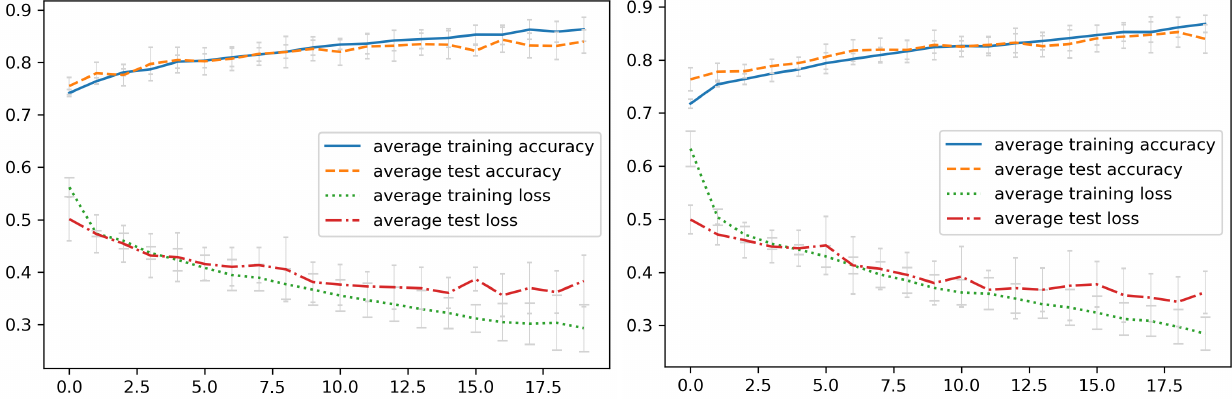
Figure 17. Left image: single dropout. Right image: double dropout. Summary of average results for 20 iterations. Class 0 vs. All. Model: the LeNet model from Figure 5 was applied. Cross-validation 5. Accuracy for 20 iterations of neural network training and corresponding cross-entropy